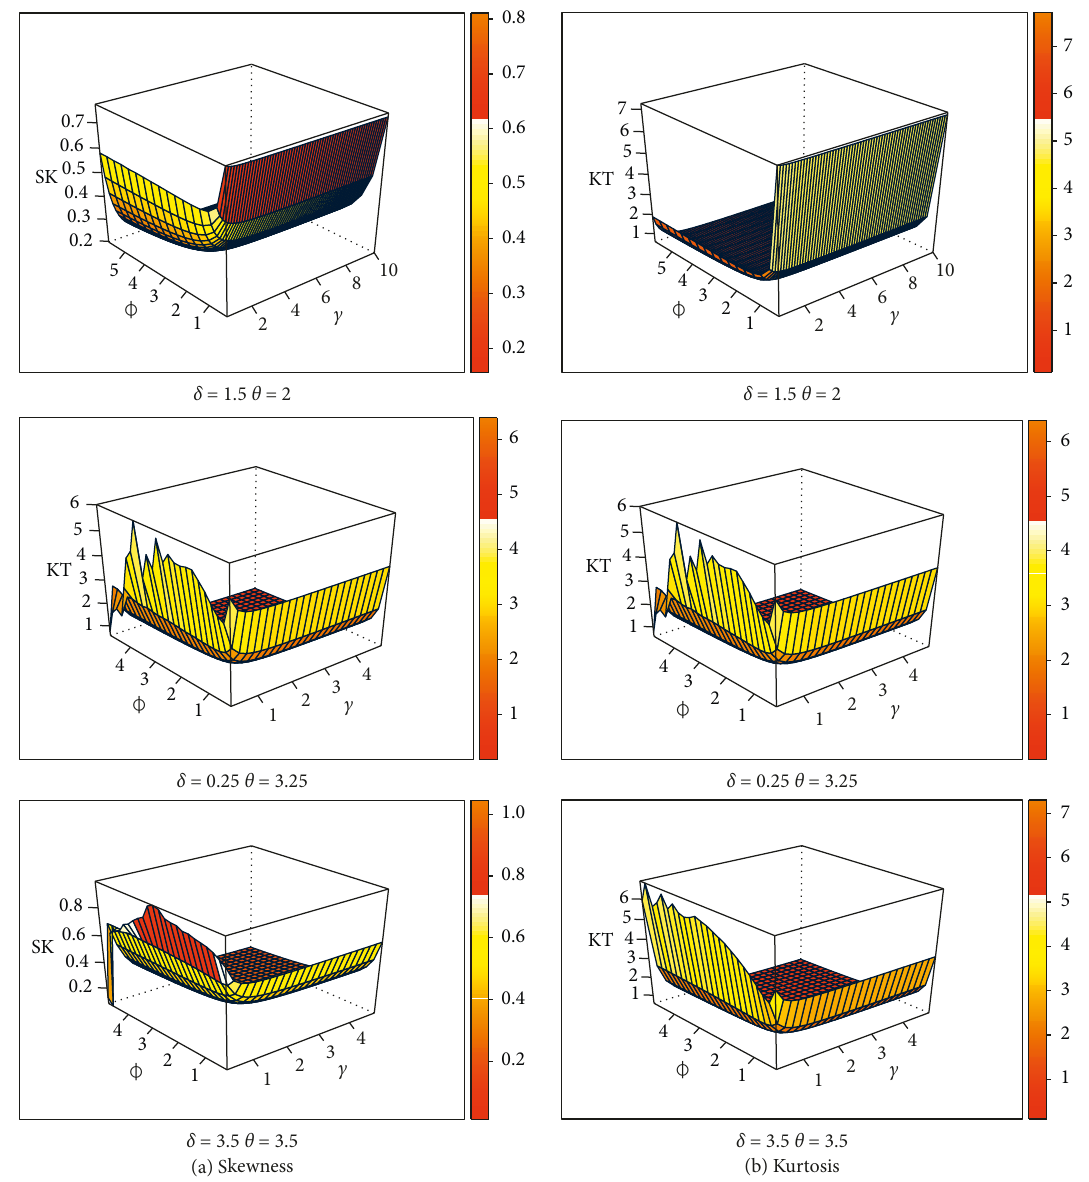
Figure 3: The 3D plots of skewness and kurtosis of IELoP distribution. (a) Skewness. (b) Kurtosis. Table 2: Some moments measures of IELoP